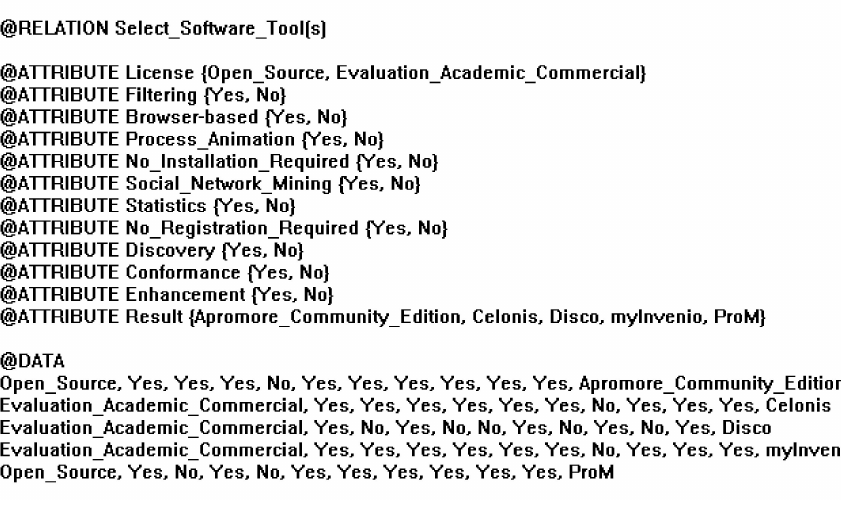
Figure 6. Data used for the generation of the decision